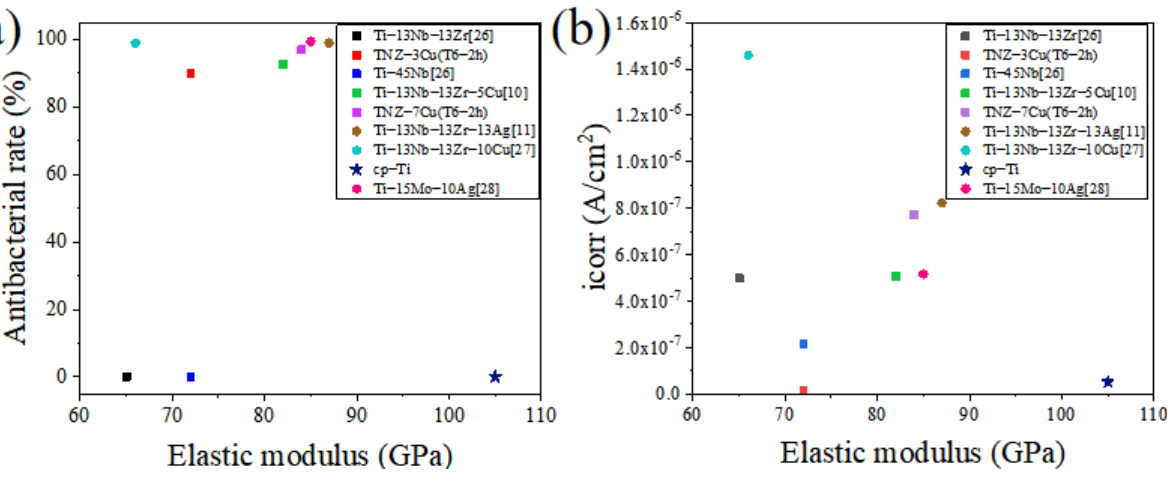
Figure 15. The result diagrams of elastic modulus, antibacterial effect, and self-corrosion current density ( i corr ) between titanium alloys: ( a ) The elastic modulus and antibacterial results of the titanium alloys, ( b ) the elastic modulus and self-corrosion current density results of the titanium alloys.